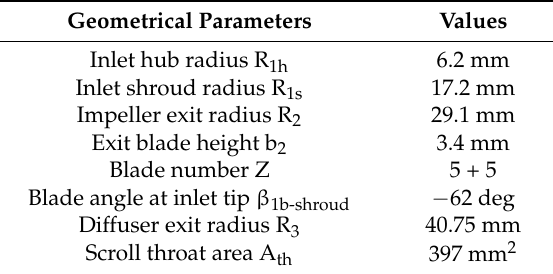
Table 2. Main compressor geometry [4].